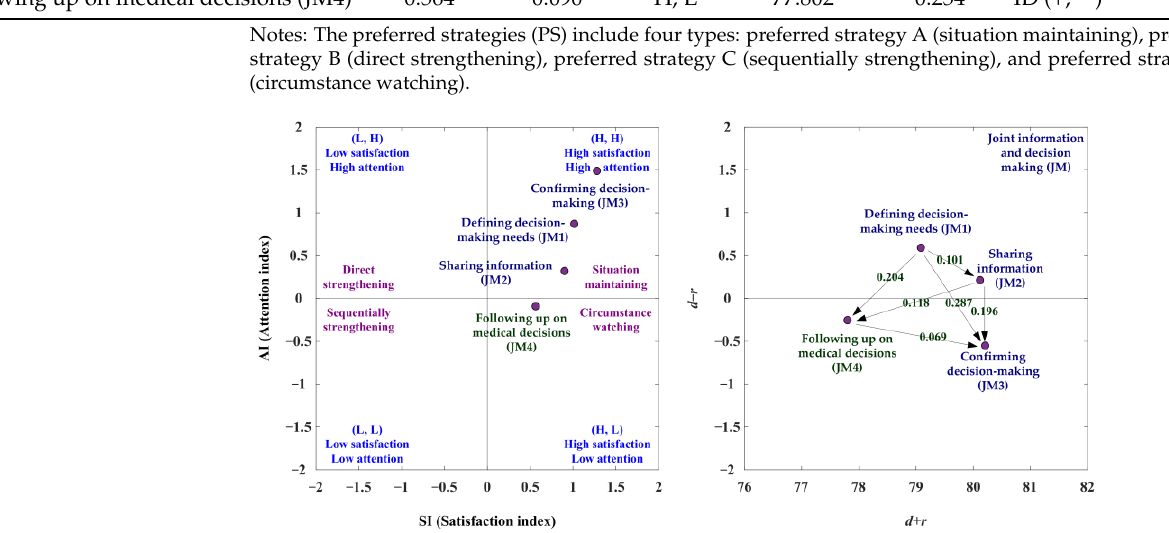
Figure 6. The development strategies map of the joint information and decision making (JM) as- pect. Table 15. The development strategies of joint information and decision making (JM) aspect.